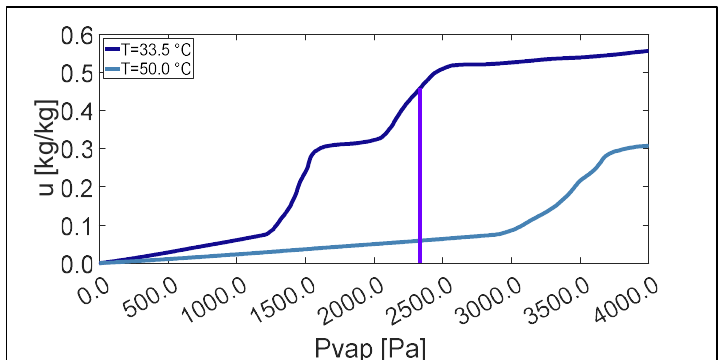
Figure 11. Isotherms of MOF MIL-100 (Fe) [6].